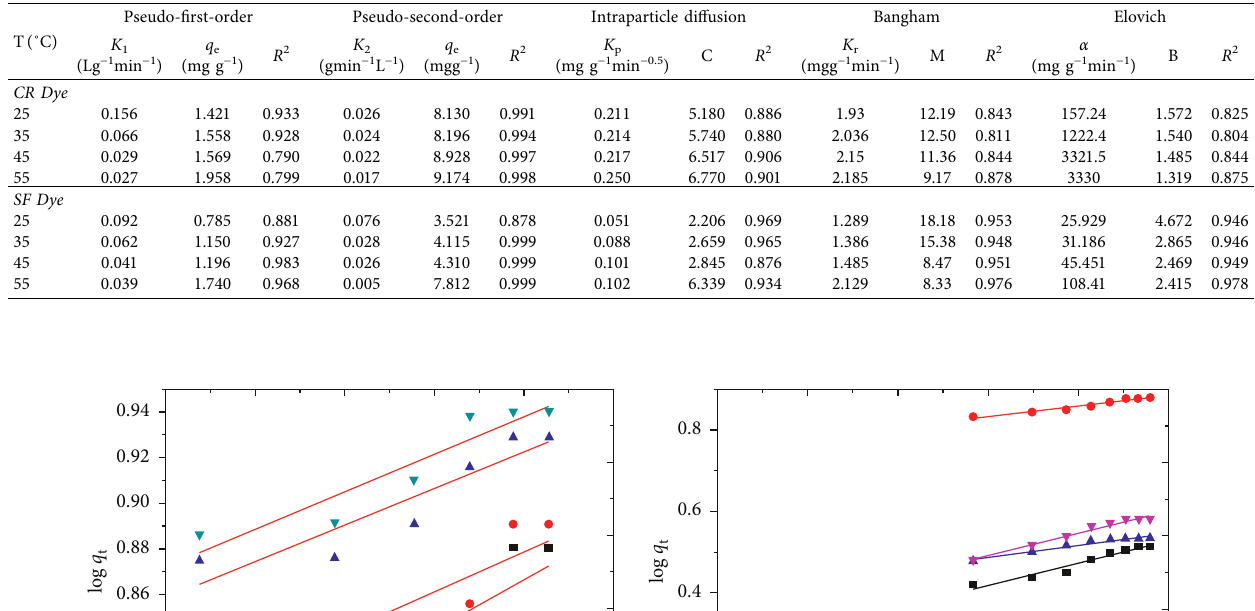
Table 2: Kinetic constants for adsorption